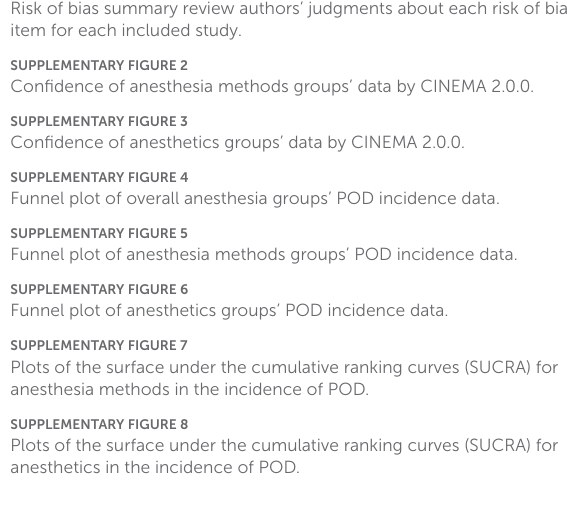
SUPPLEMENTARYFIGURE5 Funnel plot of anesthesia methods groups’ POD incidence